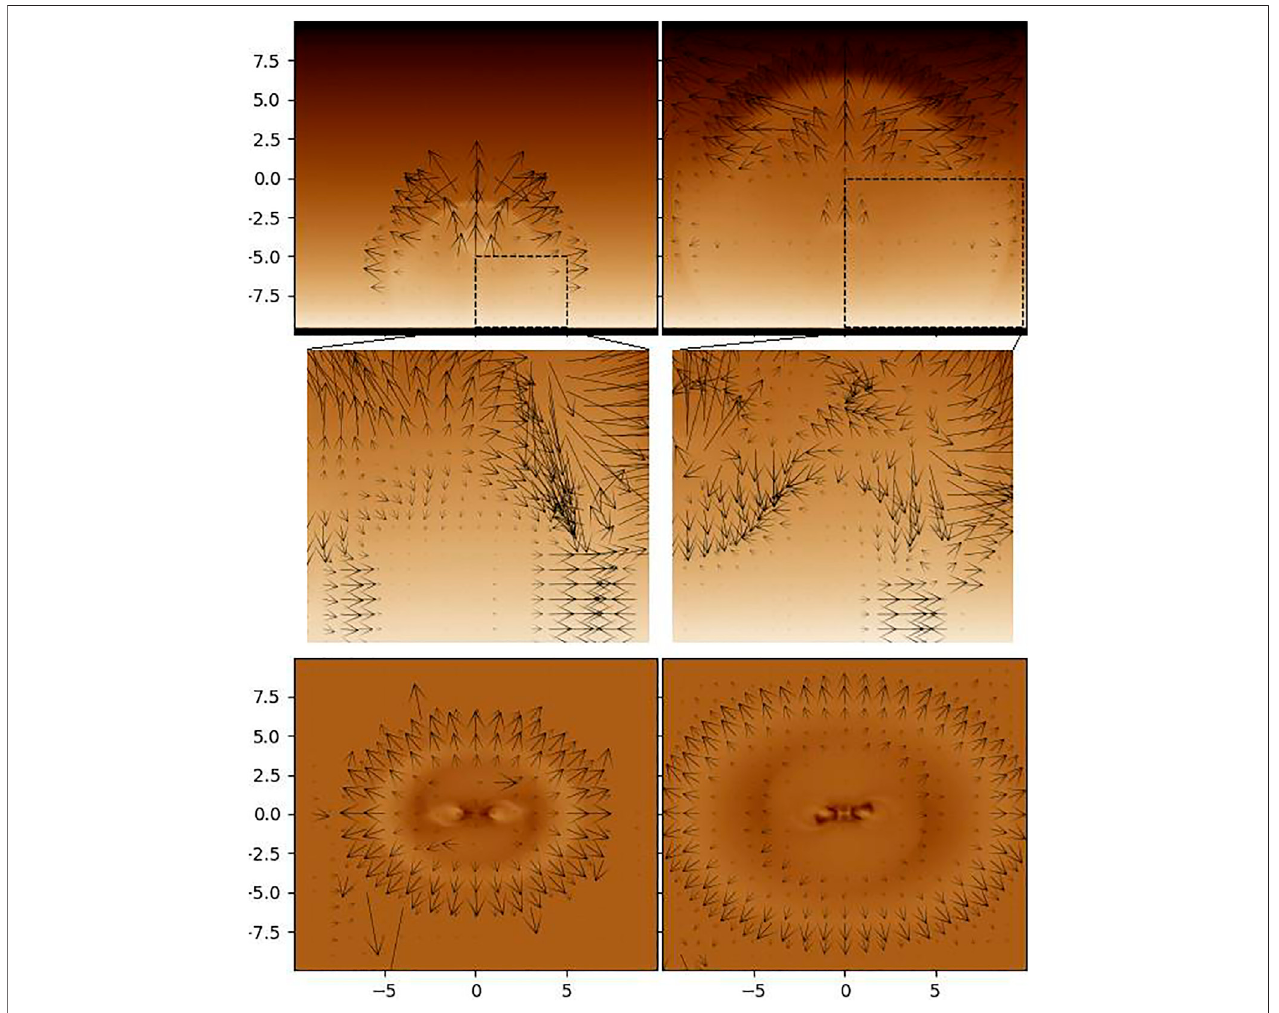
FIGURE6| SyntheticimagesofAIA193ÅinthePOSinalog-scalewithviewangles L (cid:2) 90 ° and B (cid:2) 90 ° (toprow) and L (cid:2) 0 ° and B (cid:2) 0 ° (bottomrow) at t (cid:2) 2+ Δ t and 4 + Δ t . Here, Δ t (cid:2) 0.0023. The middle low is an enlarged version of two regions marked by two black boxes on the top low. The black arrows illustrate velocity distributions on the POS, which are deduced by the Fourier local correlation tracking software (FLCT) based on the synthetic images.